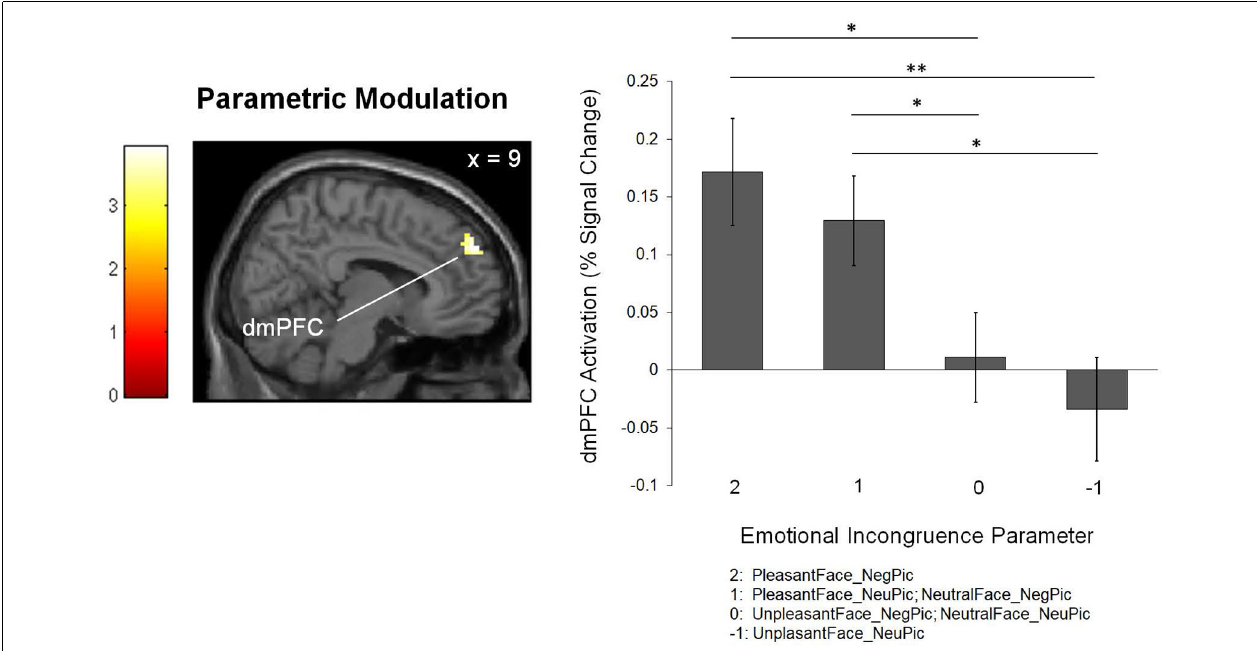
FIGURE 3 | The brain region associated with the level of emotional incongruence. The bar graph shows the percent signal changes in the corresponding region. ∗ p < 0.05, ∗∗ p < 0.01.